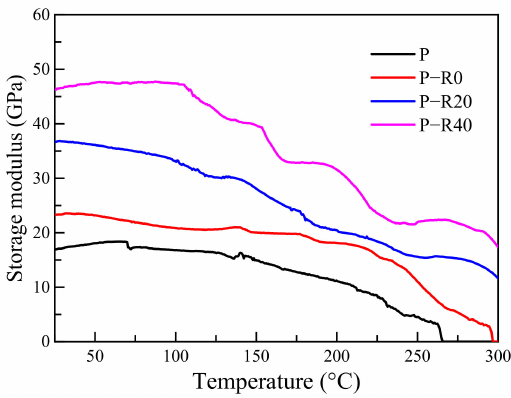
Figure 4. Storage modulus of control and modified wood specimens.